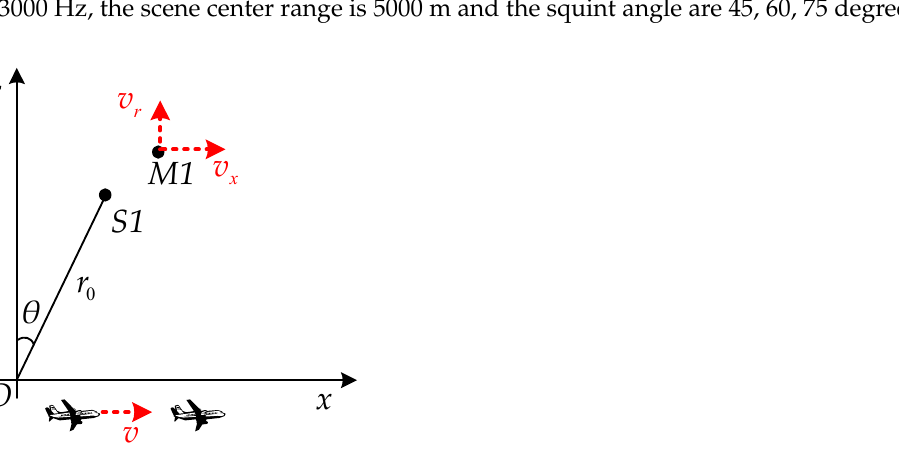
Figure 7. Point targets scene.